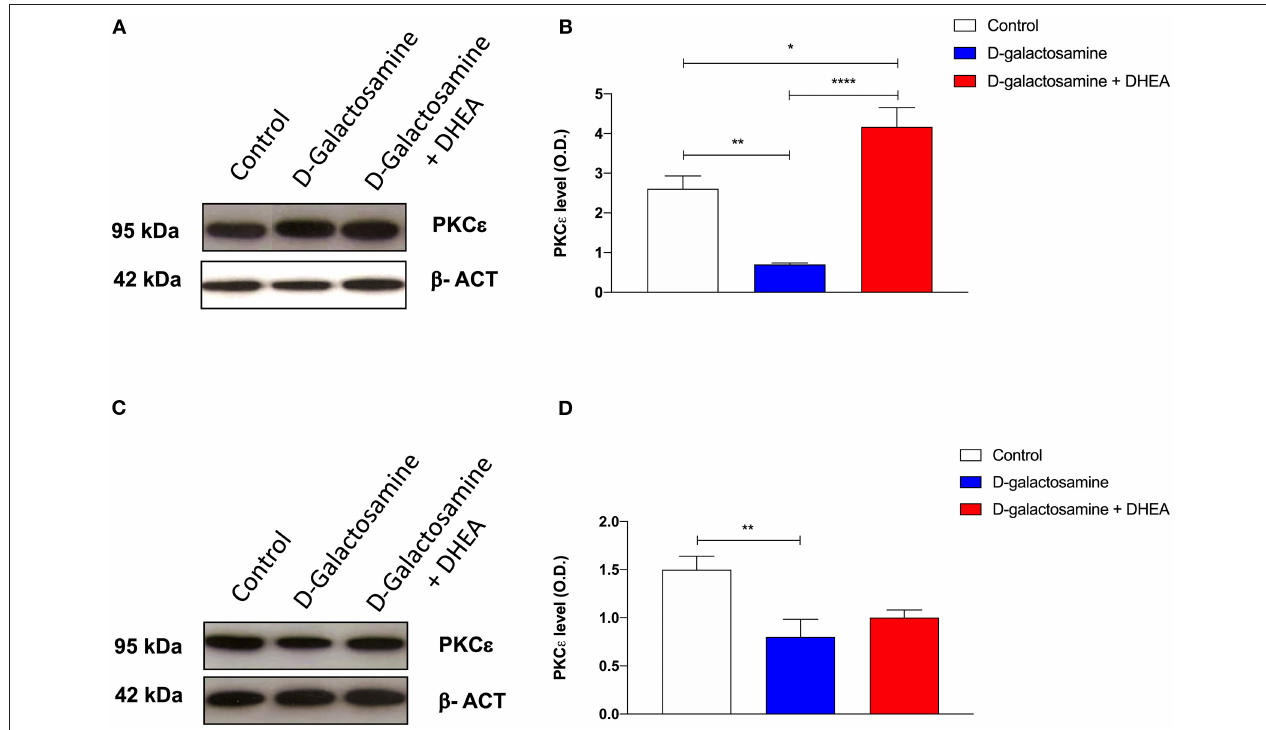
FIGURE 3 | Western blot analysis of cortex (A) and cerebellum (C) PKC ε expression after 48h of treatment with saline (control), D-galactosamine, and D-galactosamine + DHEA ( β -actin was used as internal standard) and their respective representative blots (B,D) ; * P < 0.05, ** P < 0.01, **** P < 0.0001. Western blot pictures were sliced since cortex and cerebellum samples were loaded in wells far from the